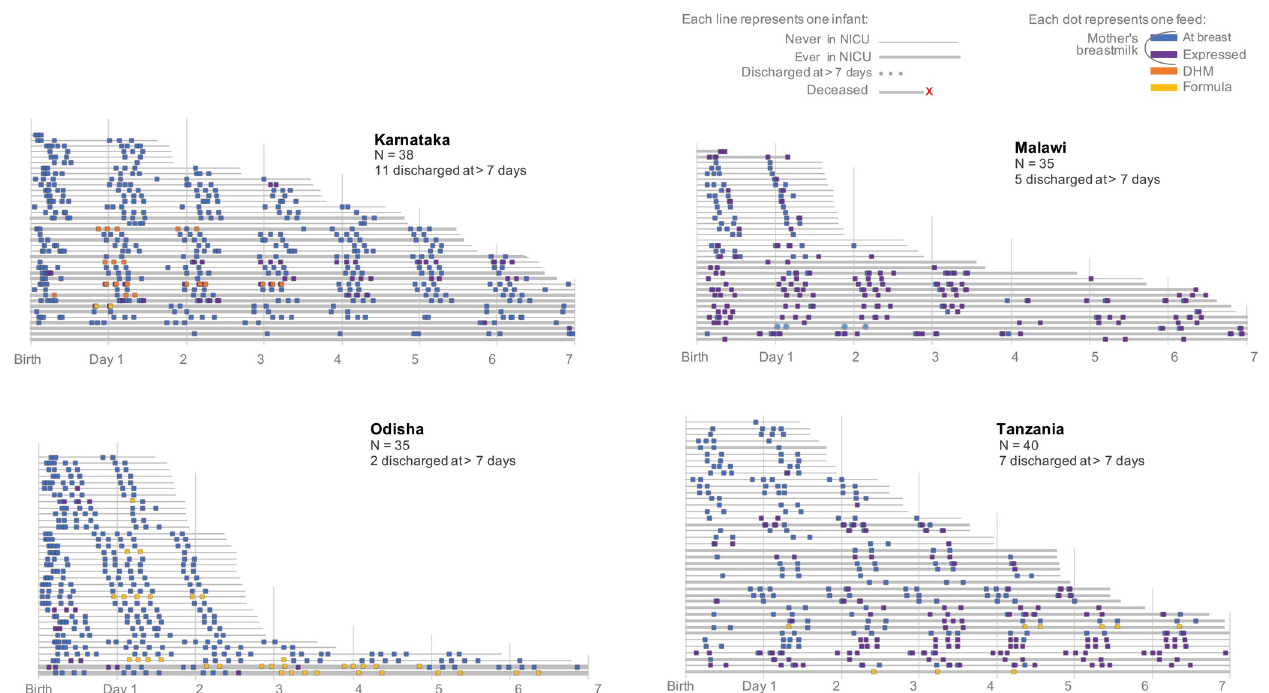
Fig 1. Observed feeding patterns in the first week of life prior to facility discharge among moderately low birthweight infants across 12 facilities in India, Malawi, and Tanzania.